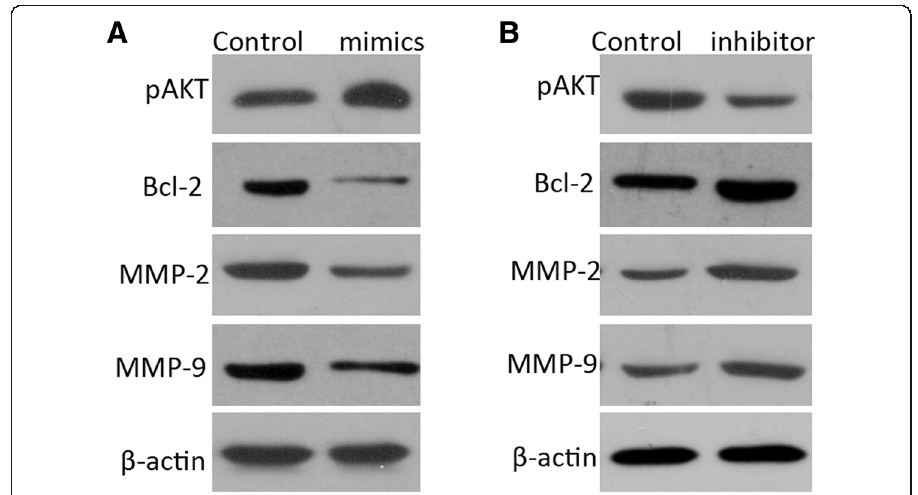
Fig. 5 Impact of miR-221 in Akt pathway. a , b Western blot analysis of pAkt, cyclin D, Bcl-2, and MMP2/9 of cells following transfection with miR-221 inhibitor or mimics. β -actin was used as a negative